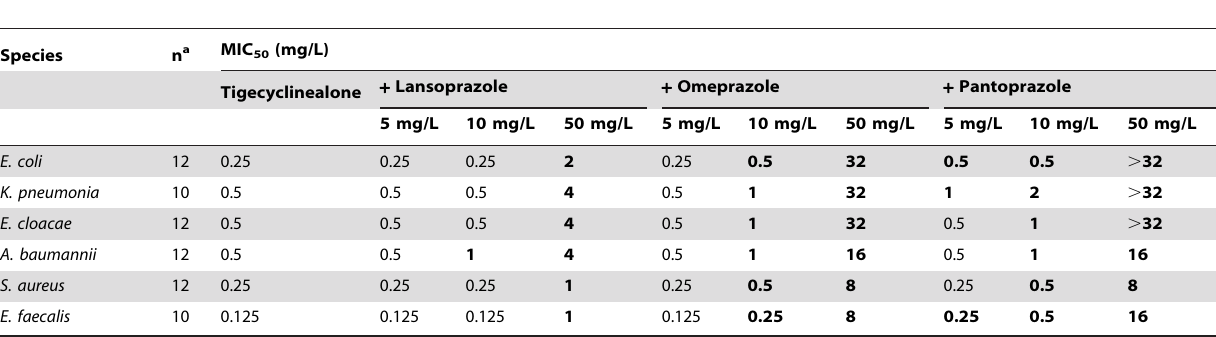
Table 1. Effect of the proton pump inhibitors (PPIs) lansoprazole, omeprazole and pantoprazole at three different concentrations on the MICs of tigecycline in clinical isolates of 6 species of pathogens.